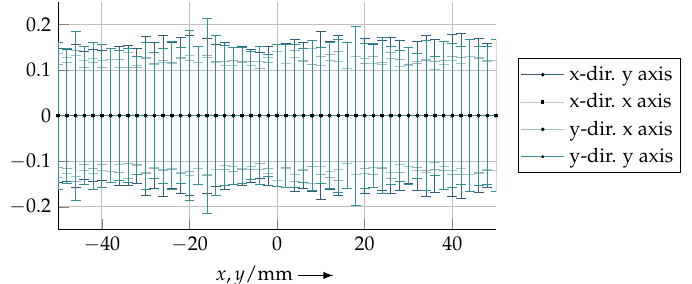
Figure 8. Positioning noise (1 σ ) of the x and y interferometer in x and y direction from position −50mm to 50mm in a distance of 2mm. This noise was recorded for a time of 10s each with a frequency of 10 kHz.